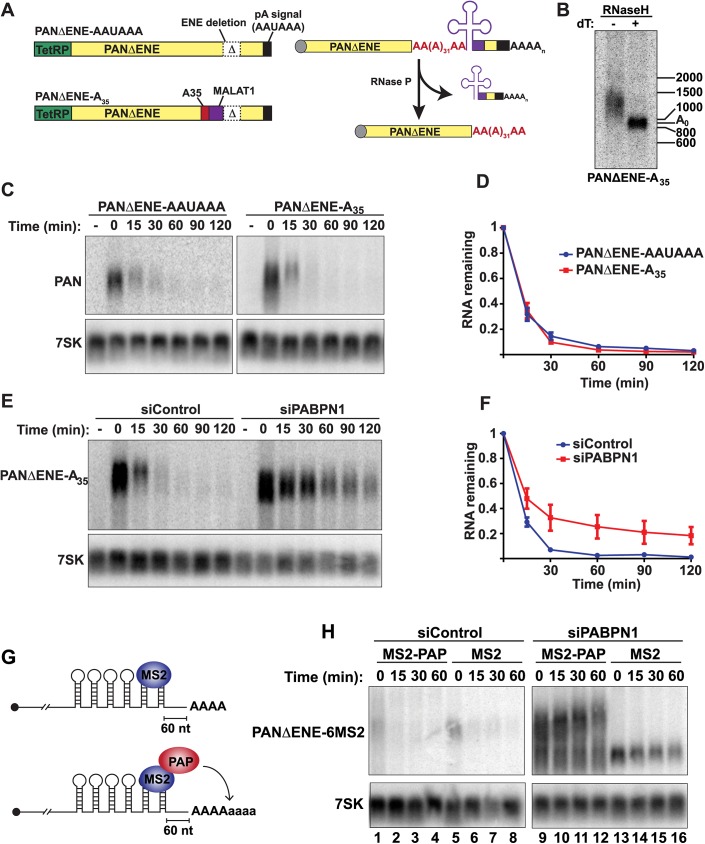
Role of hyperadenylation in PPD.
(A) Left, Cartoons of the PANΔENE-AAUAAA and PANΔENE-A35 plasmids depicting the TetRP (green), PAN RNA sequence (yellow), PAN RNA polyadenylation signals (black), A35 stretch (red), MALAT1 3´-end cleavage sequence (purple), and the position of the ENE deletion (Δ); the diagrams are not to scale. Right, Scheme of the production of PANΔENE-A35 by RNase P cleavage in cells. The color scheme is the same as the DNA diagrams; the cap is shown as a gray circle. The MALAT1 mascRNA sequence is represented by the cloverleaf structure. (B) Poly(A) tail length analysis of PANΔENE-A35. RNA was harvested and treated with RNase H in the presence or absence of oligo(dT). (C) Representative transcription pulse-chase assay with the indicated constructs. The “-” samples were harvested prior to the two-hour transcription pulse. 7SK RNA was used as a loading control. (D) Quantification of the pulse-chase assays; error bars show the standard deviation of the mean (n = 3). (E and F) Representative transcription pulse chase and quantification of PANΔENE-A35 following treatment with the indicated siRNAs (n = 3) (G) Illustration of the PAP-tethering approach. (H) Transcription pulse-chase analysis of TetRP-driven PANΔENE containing six MS2 binding sites. Cells were treated with either control (left) or PABPN1 (right) siRNAs. Cells were co-transfected with PANΔENE-6MS2 and either MS2-PAP or MS2 expression constructs.